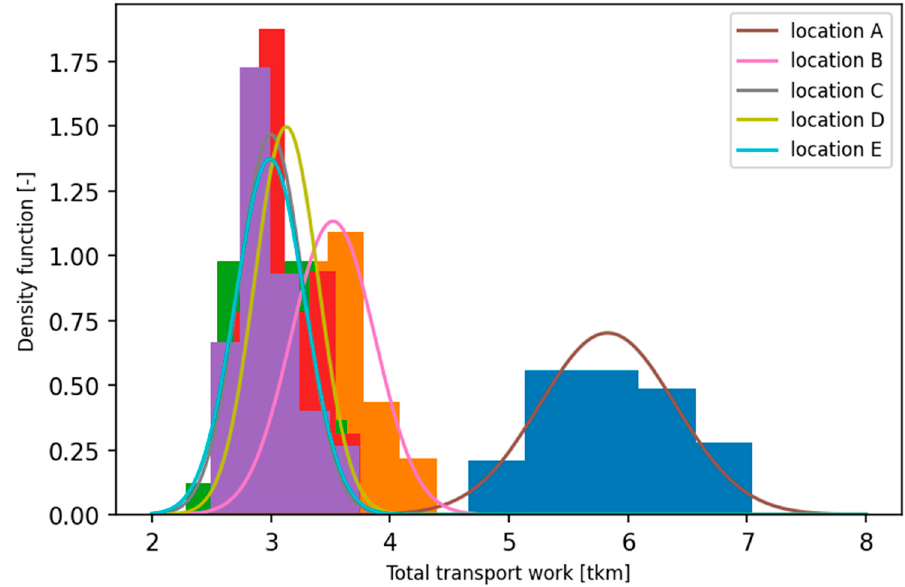
Figure 6. Distribution of the total transport work for the considered loading hub locations.